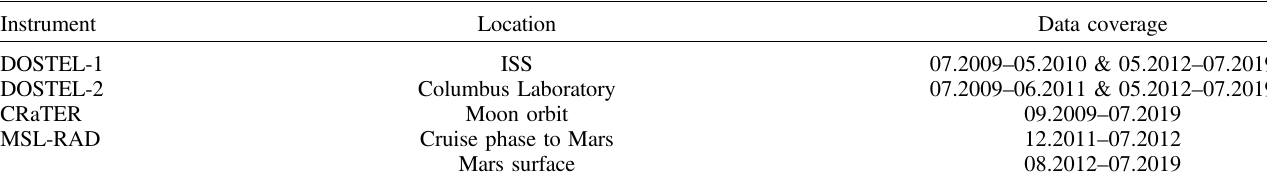
Table 1. Relevant data coverage by the instruments for this study. Instrument